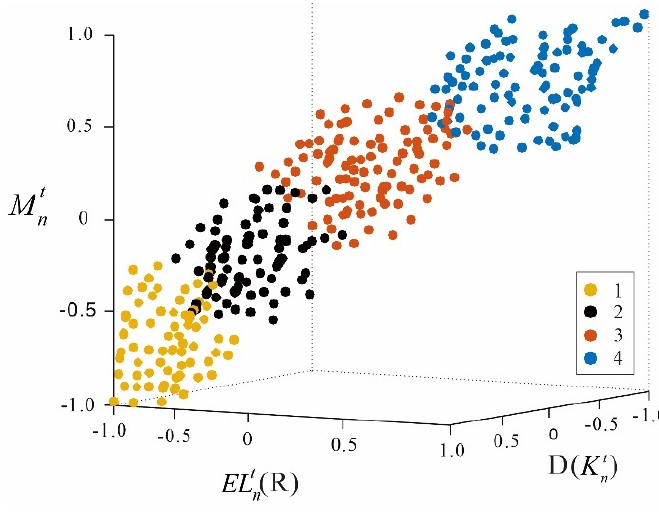
Figure 7. K-means++ clustering result.